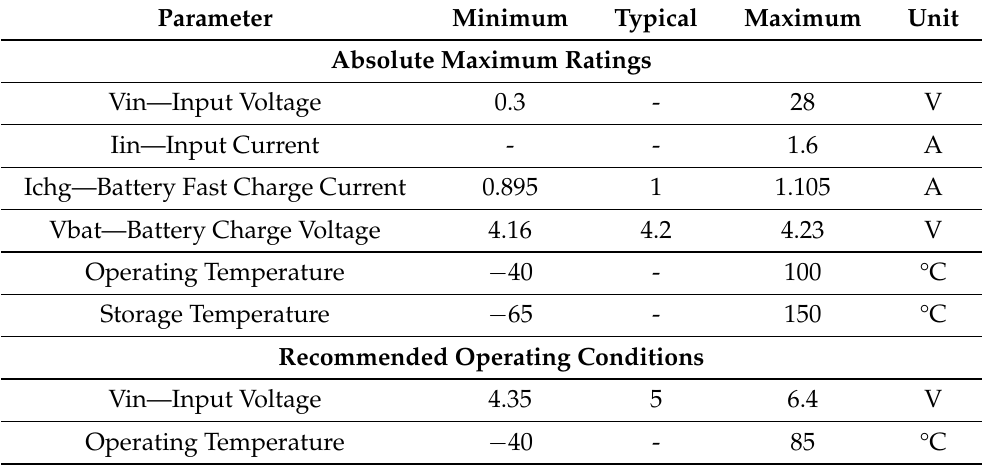
Table 3. Electrical characteristics of